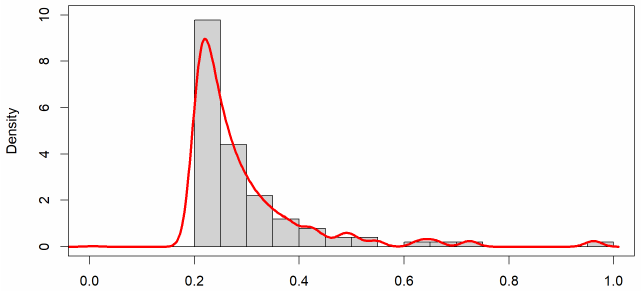
Figure 5. Pareto